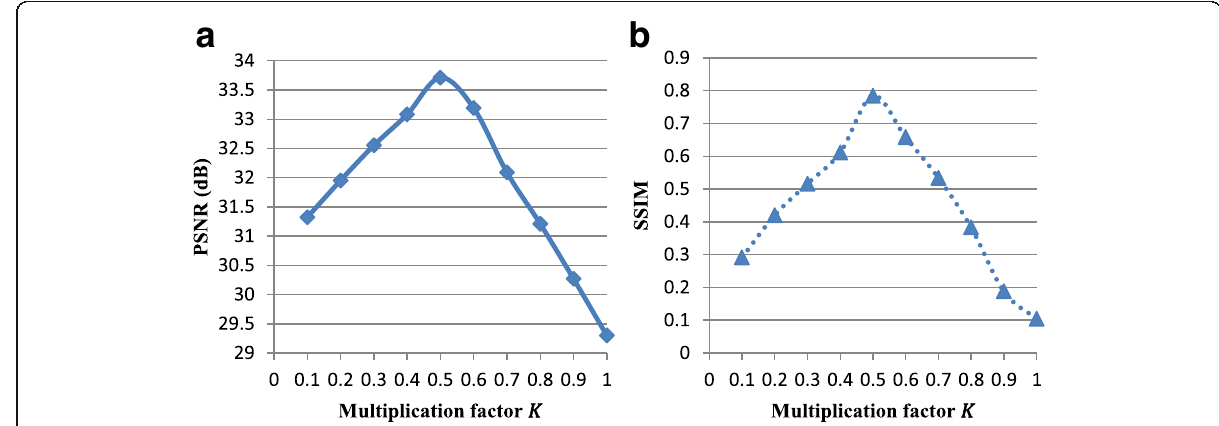
Fig. 5 Graph of variation of PSNR and SSIM with variation in multiplication factor K . Legends: a PSNR vs. K and b SSIM vs.